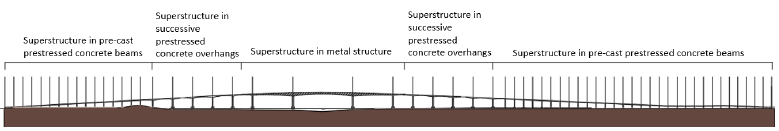
Figure 2. Third Bridge VIXBR design.